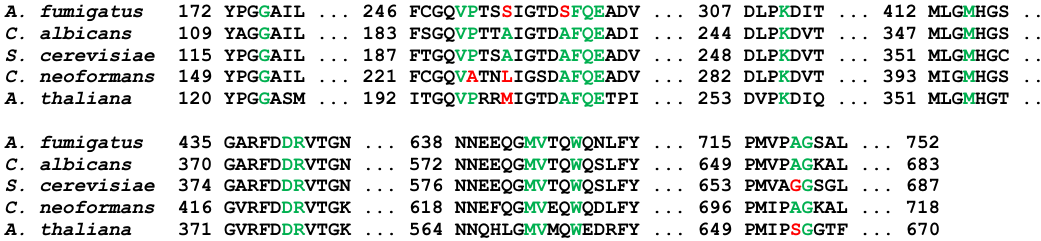
C. neoformans 149 YPGGAIL ... 221 FCGQVATNLIGSDAFQEADV ... 282 DLPKDVT ... 393 MIGMHGS ... A. thaliana